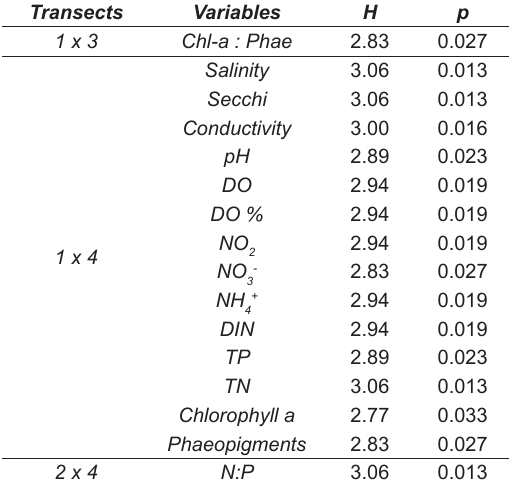
Table 2. Significant variations found between the sampling transects at Iguaçu River’s mouth